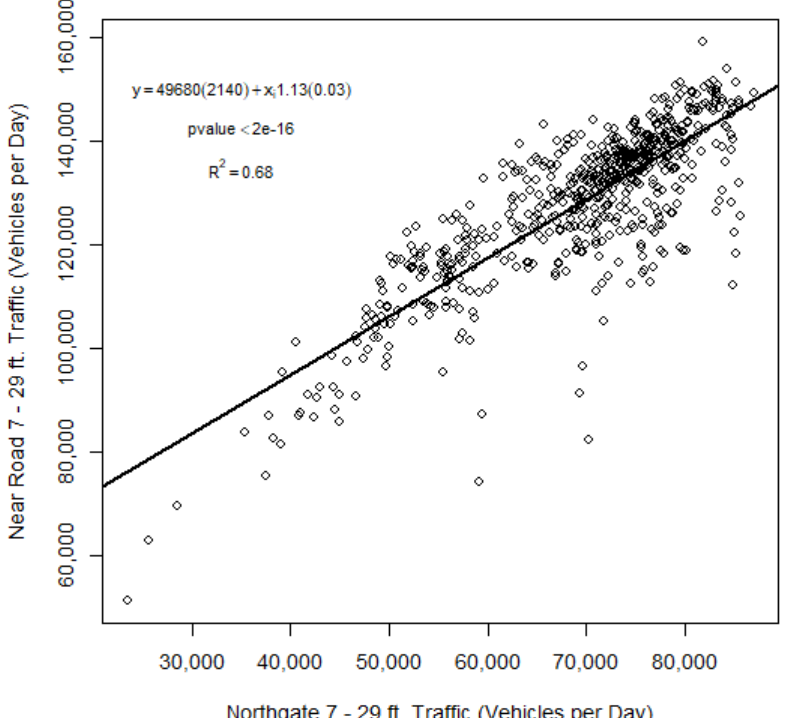
Figure 5. Results of using Northgate 7–29 ft traffic counts to predict Near Road 7–29 ft traffic counts via linear regression. The regression equation, p -value for fit of predictor, and R 2 are shown in the top left of the